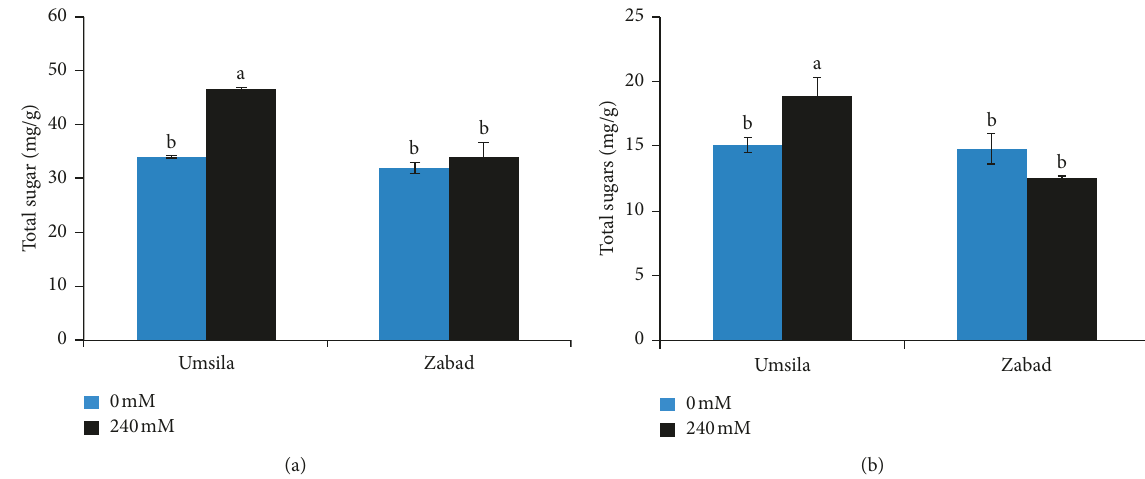
Figure 7: Differential accumulation of soluble sugars in leaves (a) and roots (b) of the salt-tolerant cultivar Umsila and susceptible Zabad cultivars due to salt treatment. Bars represent mean ± SE ( n � 3). Statistical differences between the treatments were calculated based on p ≤ 0 .